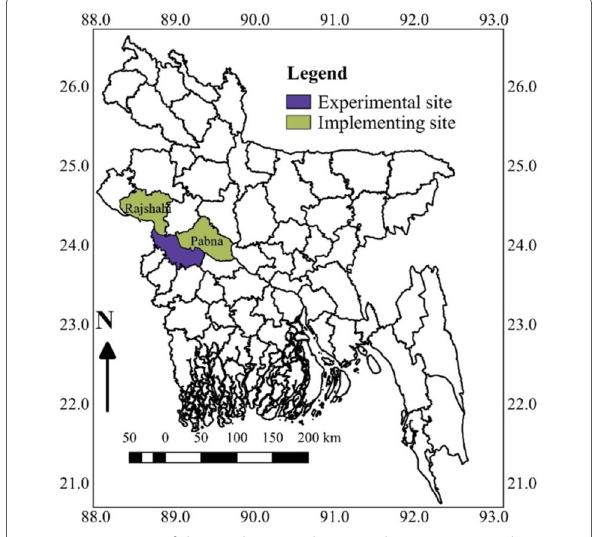
Fig. 1 Locations of the study areas showing the experimental site (Kushtia) and the implementing sites (Pabna and